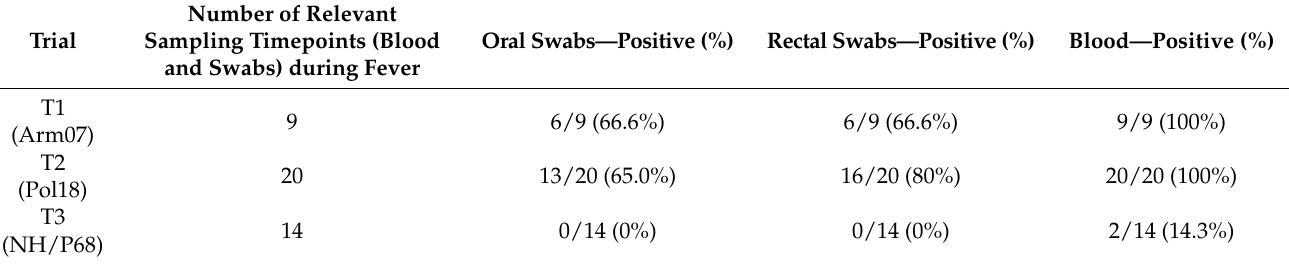
Table 5. Percentage of PCR-positive samples collected during fever